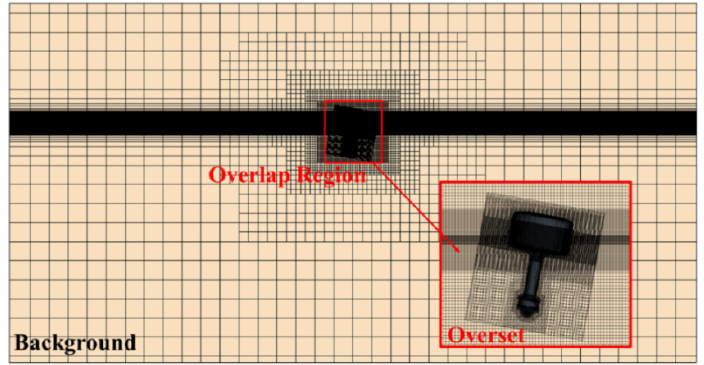
Figure 9. Grid system for the free decay test of lightweight light buoys using CFD.